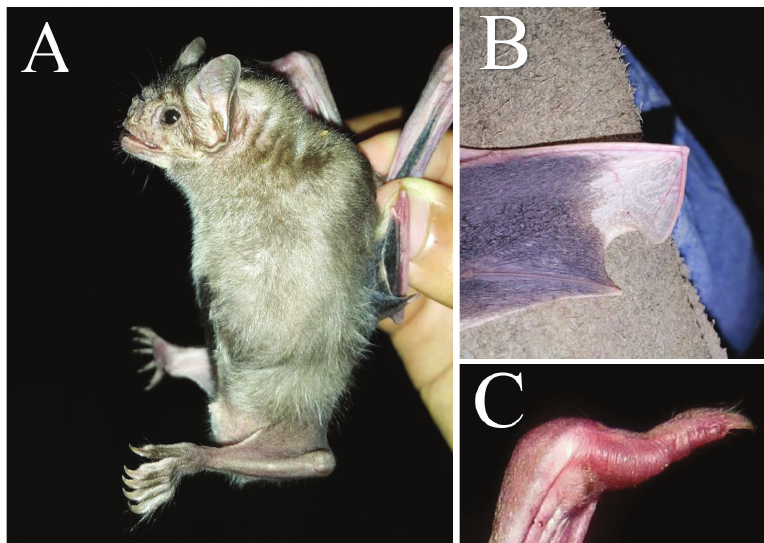
Figure 3. Diaemus youngii . A – Frosted brownish venter; B – Whitish tip of the wings; C – One pad on the base of the